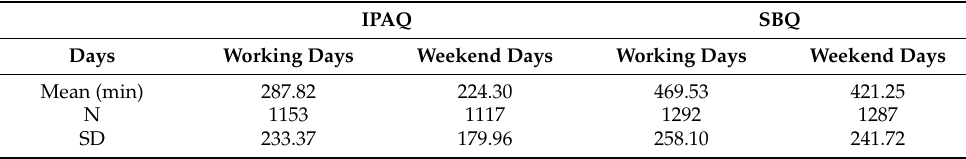
Table 2. Sitting time difference between IPAQ and SBQ measurement. IPAQ SBQ Days Working Days Weekend Days Working Days Weekend Days Mean (min) 287.82